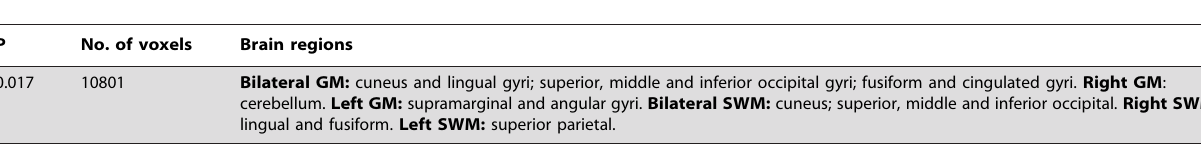
Table 4. Brain regions with negative correlation between perfusion and the number of optic neuritis attacks.